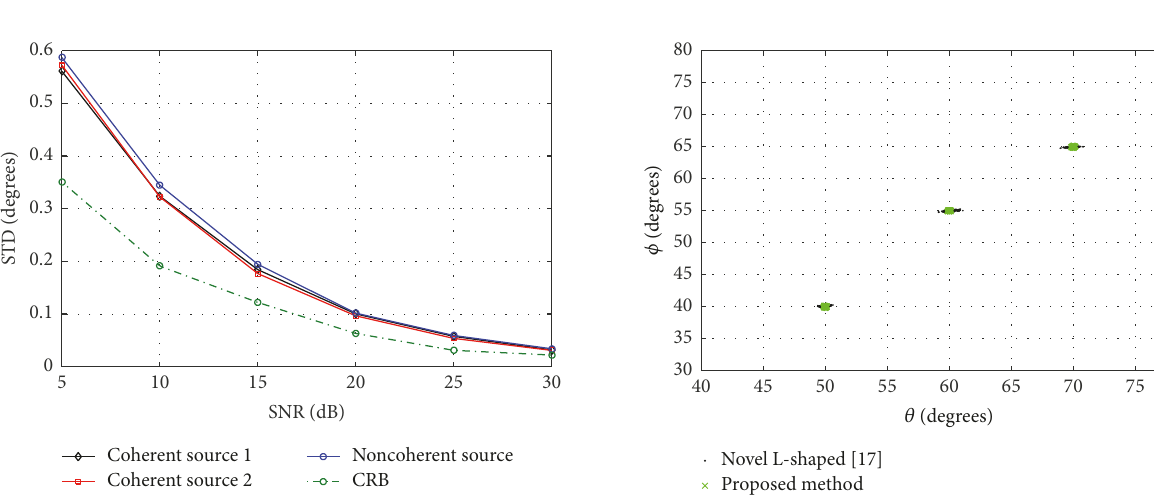
Figure 6: Standard deviation versus SNR for source 2 (coherent) located at (𝜃 2 = 80 ∘ , 𝜙 2 = 60 ∘ ) for the proposed method.